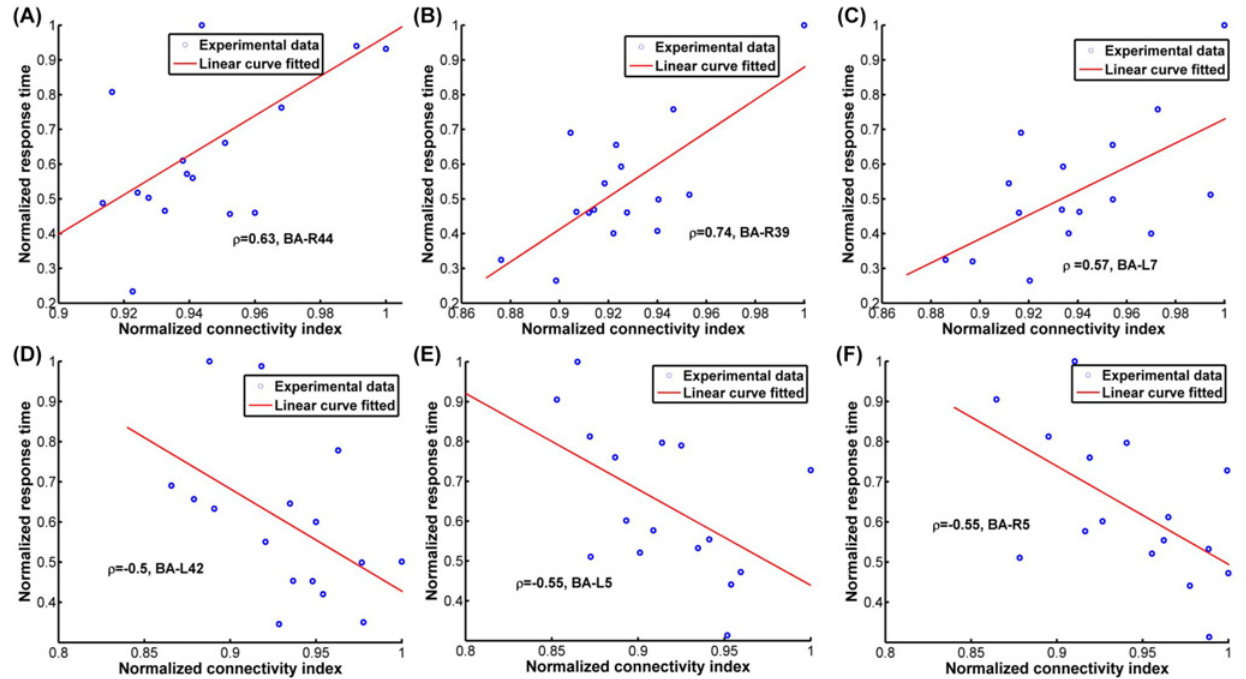
Figure 7. Several regions ’ normalized event-related clustering coefficients were found positively correlated with the normalized response time in different conditions. The event-related clustering coefficient (normalized) of the inferior frontal gyrus (a) was found to be positively correlated with the response time (normalized) in the WE-IL condition (corrected p < 0.05). The event-related clustering coefficients of the angular gyrus (b) and precuneus (c) were found to be positively correlated with the response time (normalized) in the WE-IT condition (corrected p < 0.05). The event-related clustering coefficient (normalized) of the secondary auditory cortex (42L) (d) was found to be marginally negatively correlated with the response time (normalized) in the NE-IL condition (corrected p = 0.058). The event-related clustering coefficient of the somatosensory association cortex (L, R) (e, f) was found to be negatively correlated with the response time (normalized) in the NE-IT condition (corrected p < 0.05). All the significance reports are based on multiple comparison permutation correlation test with corrected p < 0.05.